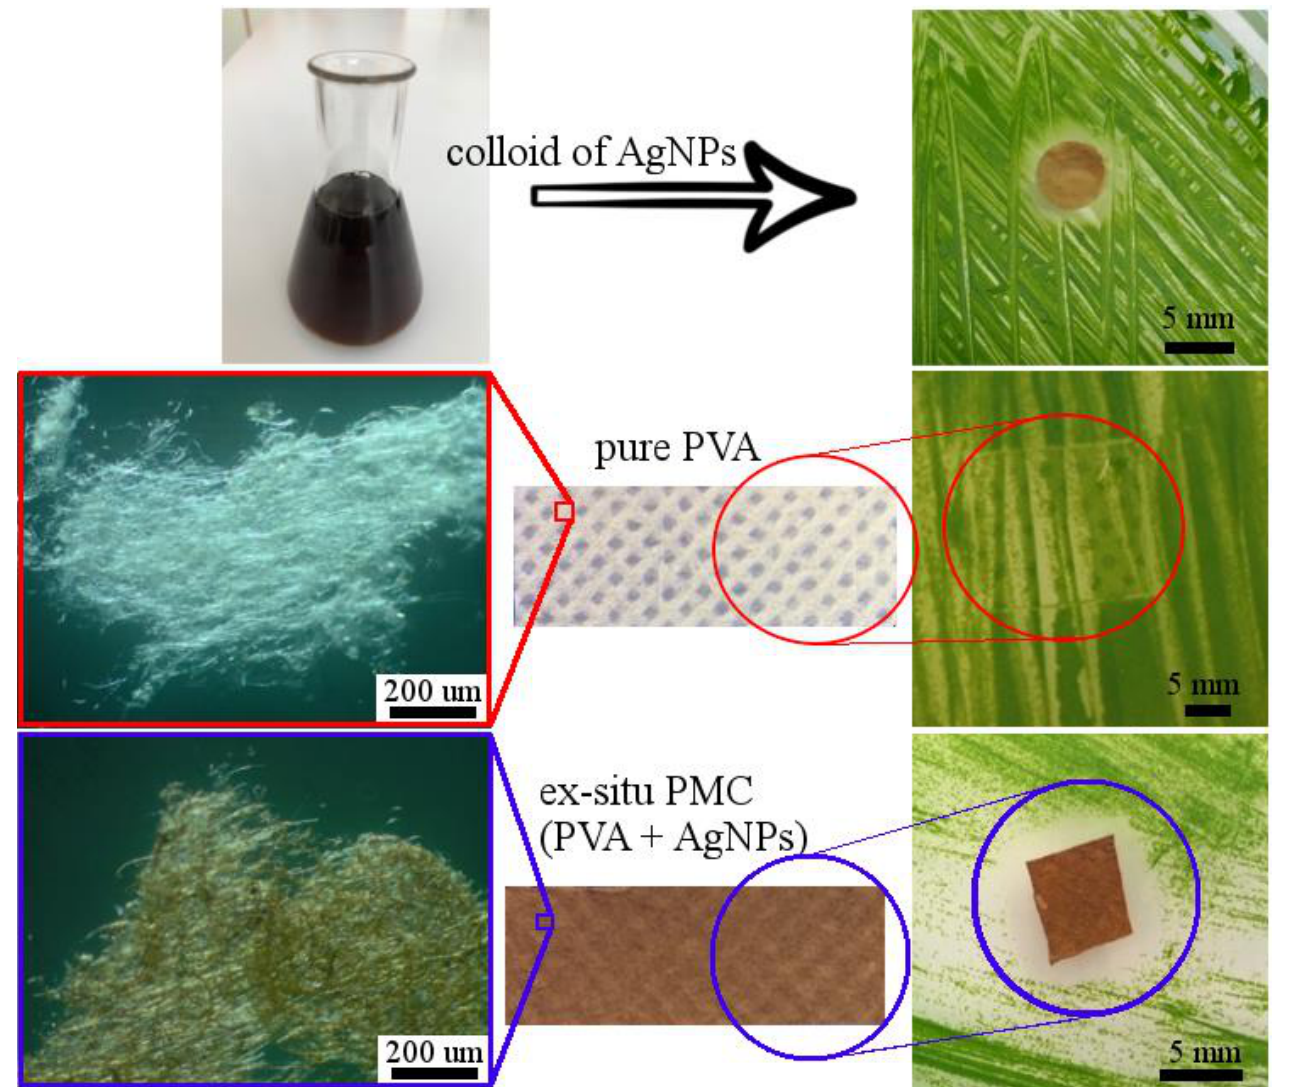
Figure 7. Toxicity test of colloidal AgNPs on one-cell green algae P. kessleri ; toxic and antibiofilm effect of pure PVA and ex situ prepared PVA-AgNPs composites with a detailed view on fibers (in top-down order).